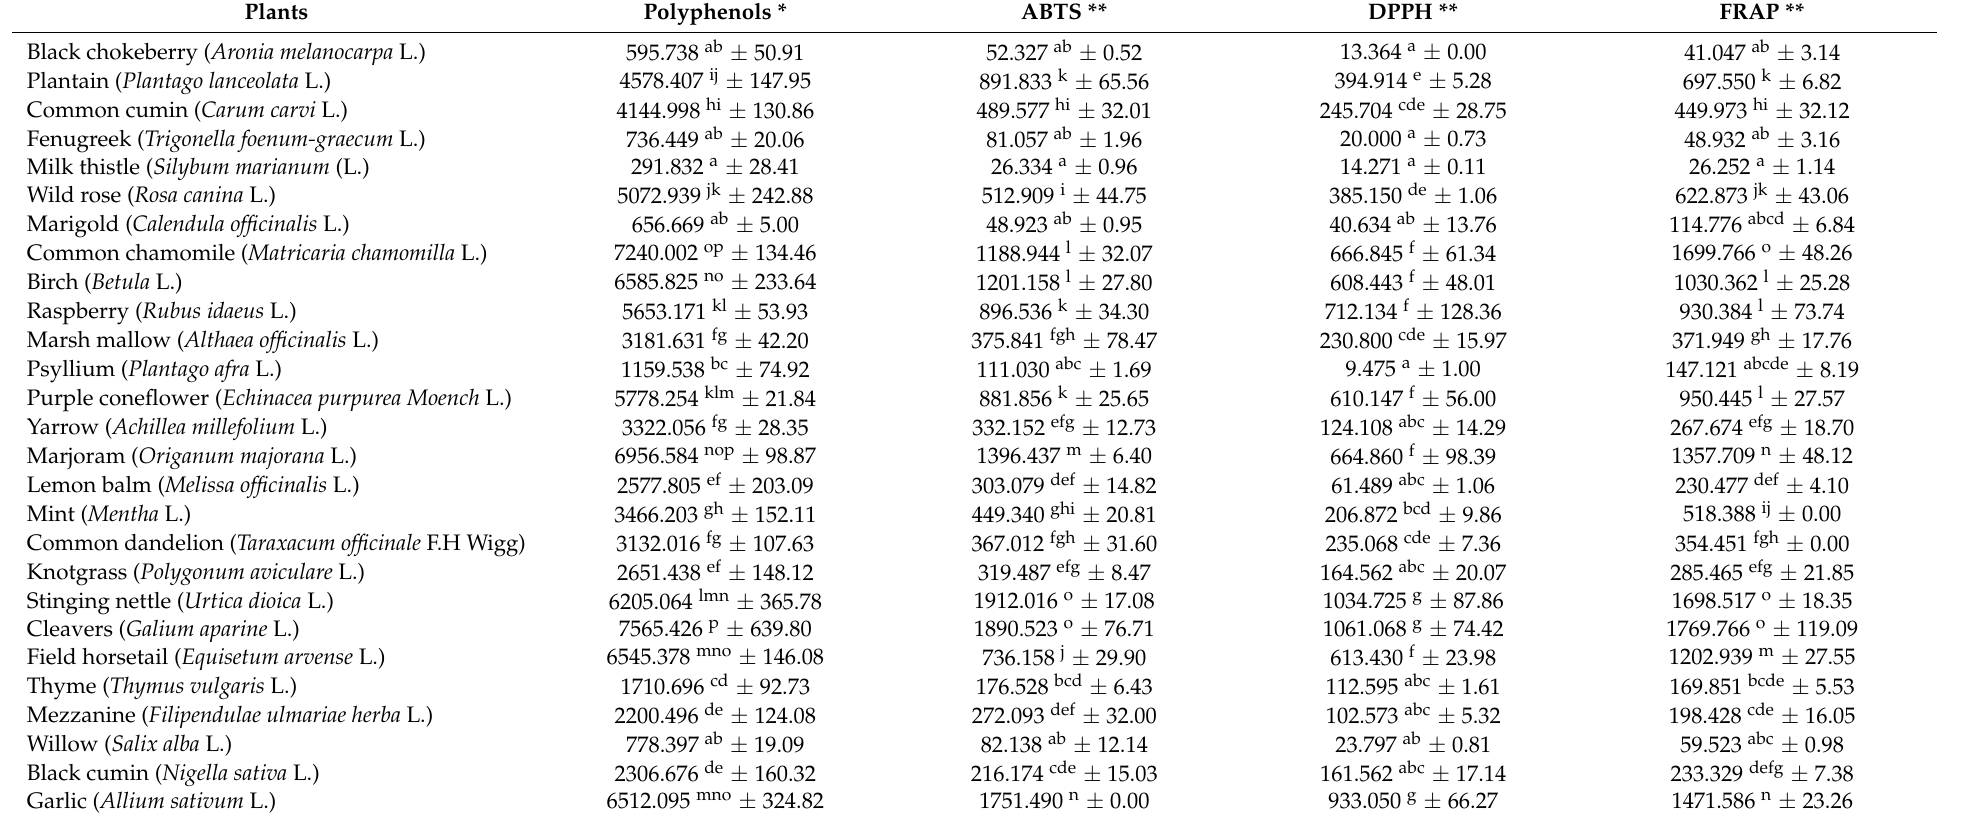
Table 3. Total polyphenol content and antioxidant activity of selected raw